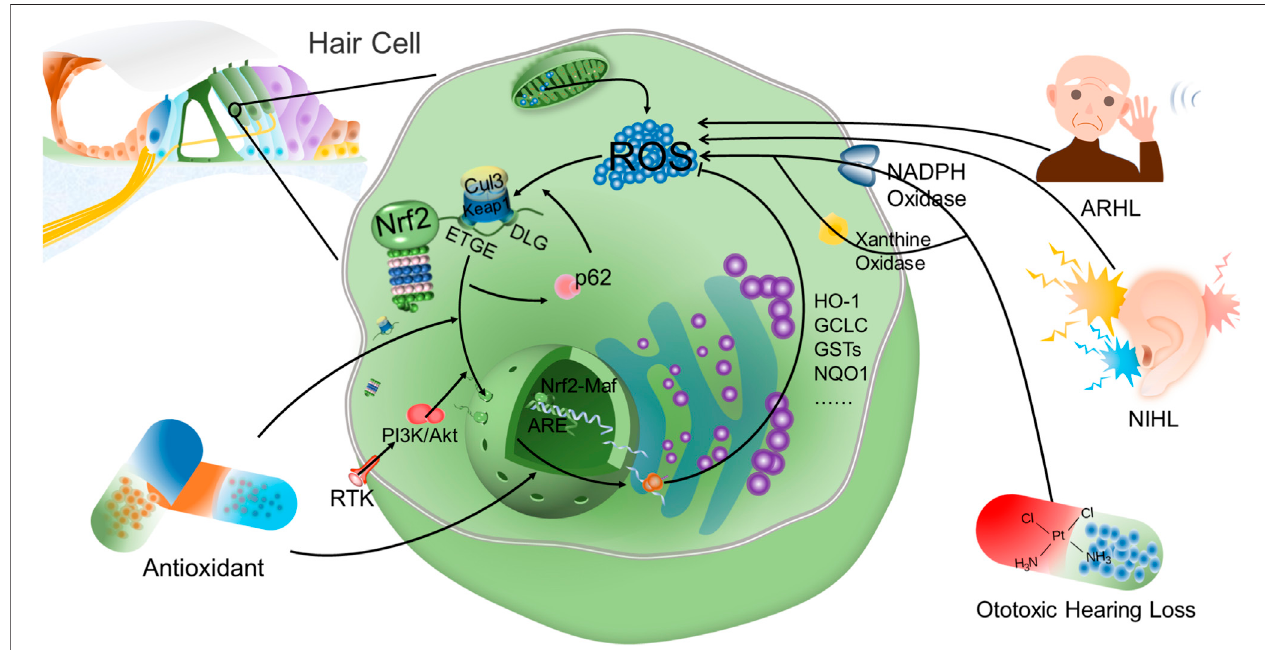
FIGURE 2 | Nrf2 is an important factor to reduce oxidative stress injury of hair cells. Under normal conditions, Nrf2 is anchored in the cytoplasm by Keap1 and is rapidly degraded by ubiquitination. However, Nrf2 is disconnected from Keap1 and translocates into the nucleus after the action of oxidative stress. Antioxidant drugs have been found to promote the intracellular translocation of Nrf2 and the transcription of downstream antioxidant products after Nrf2 bound to ARE. After activation of Keap1-Nrf2-ARE signaling axis, antioxidant factors such as HO-1 can reduce the intracellular ROS level mediated by NIHL, ARHL and ototoxic hearing loss, thereby protecting hair cells and reducing hearing loss. Moreover, there is a positive feedback between p62-mediated autophagy and Nrf2. p62 destroyed the connectionbetweenKeap1andNrf2topromotetheaccumulationofNrf2andnucleartranslocation.Concurrently,increasedNrf2promotesp62expression.Inaddition, PI3K-Akt signaling pathway is also involved in the intracellular translocation of Nrf2 in hair cells. However, in the study on hearing loss, the relationship between other signaling pathways and Nrf2 expression is still not fully